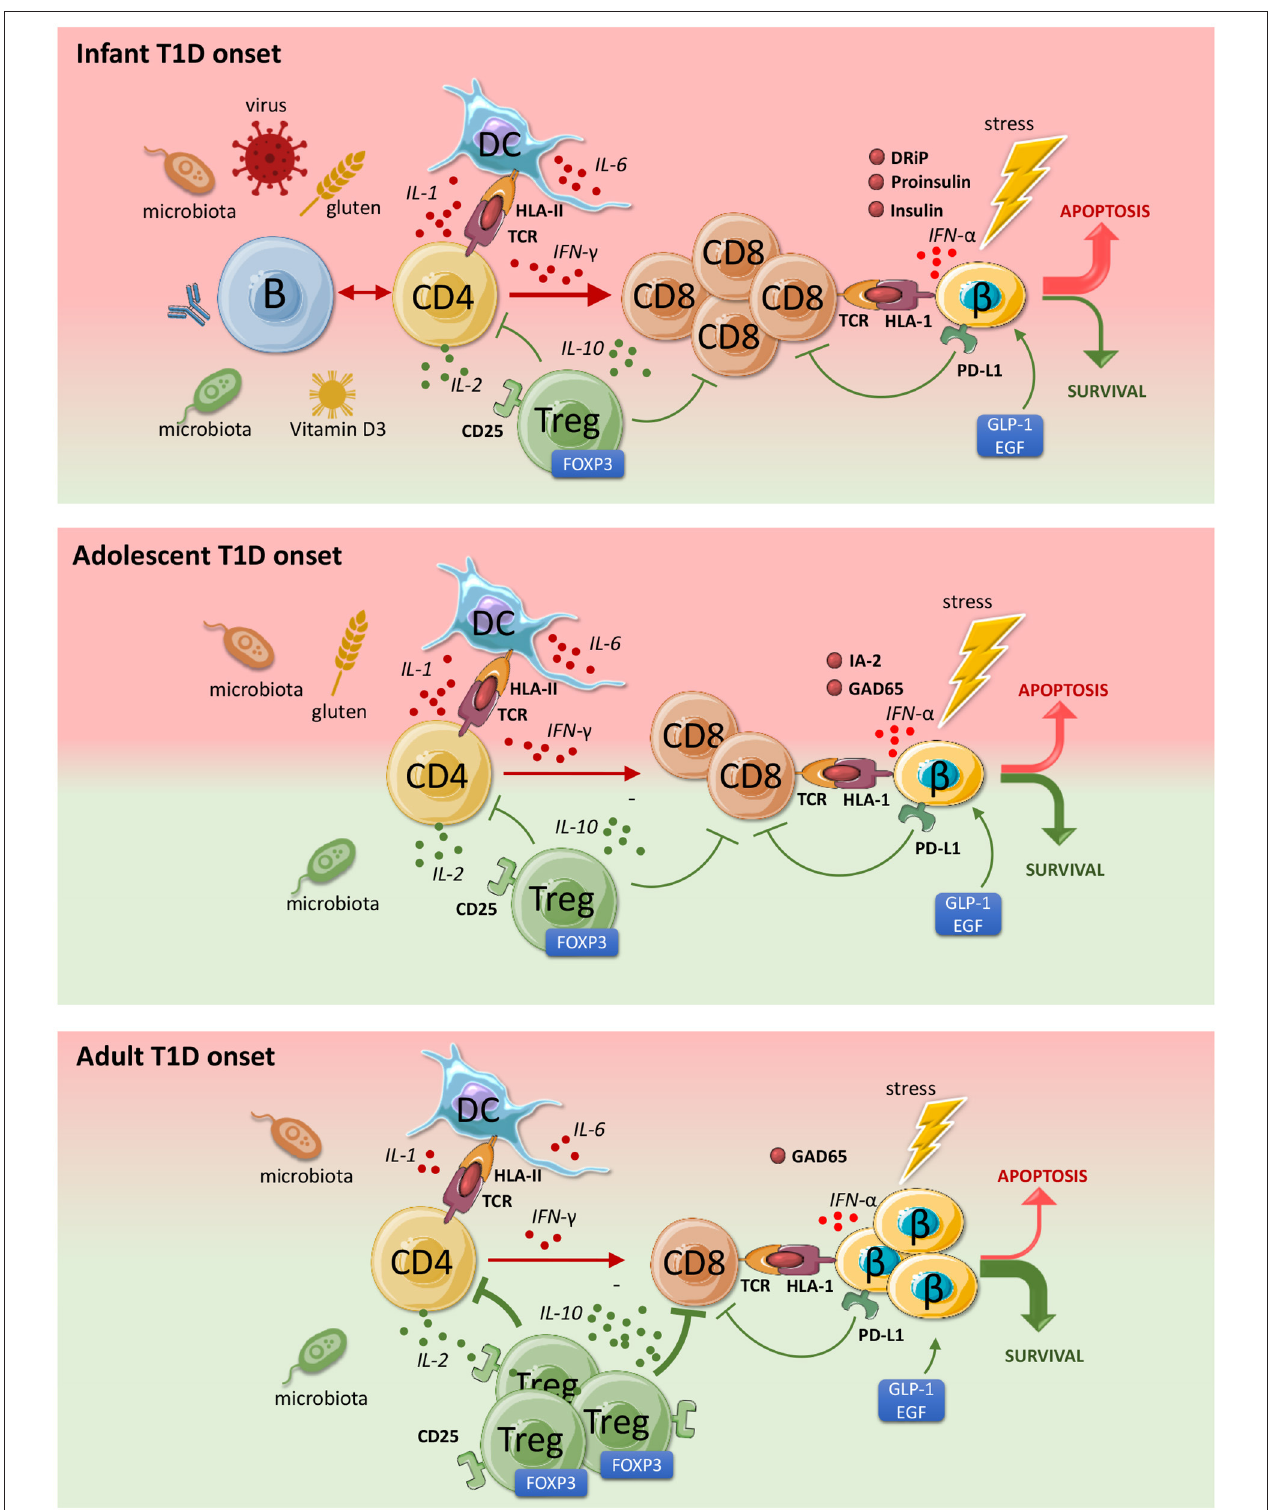
FIGURE 1 | Pathophysiology and endotypes of type 1 diabetes (T1D). Both beta-cells and the immune system can provoke and diminish autoimmunity and beta-cell destruction. The contribution of the major cell types in disease progression differs depending on the age of disease onset. Green indicates a protective role and